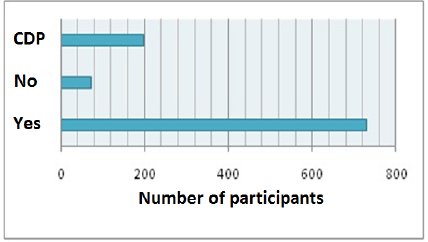
Figure.7. The reach rate for each type of